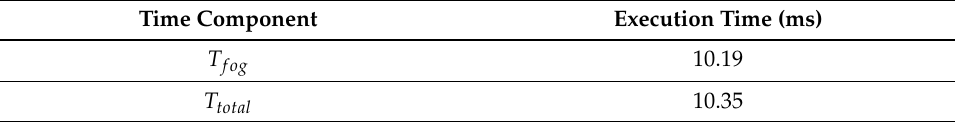
Table 3. Execution times of the fog